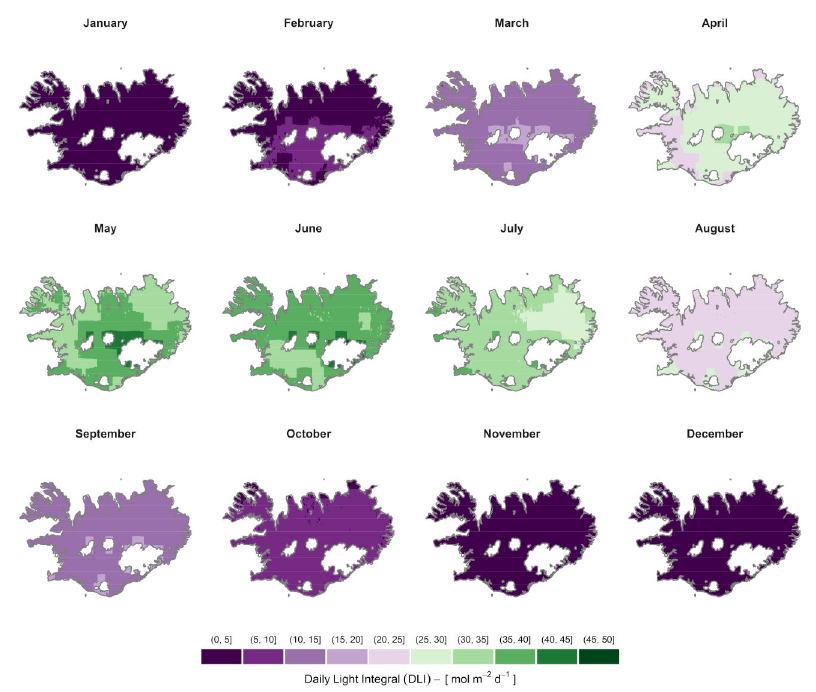
Figure A2. Monthly average photosynthetic daily light integral (DLI sun , mol · m − 2 · d − 1 ) maps for Iceland. Values from the ECMWF-ERA-5 dataset with a coverage period of 2005–2016 retrieved from PVGIS as a 0.05 ◦ × 0.05 ◦ grid both in latitude and longitude, extending from 63 ◦ N to 67.5 ◦ N in latitude and 13 ◦ W to 25 ◦ W in longitude.